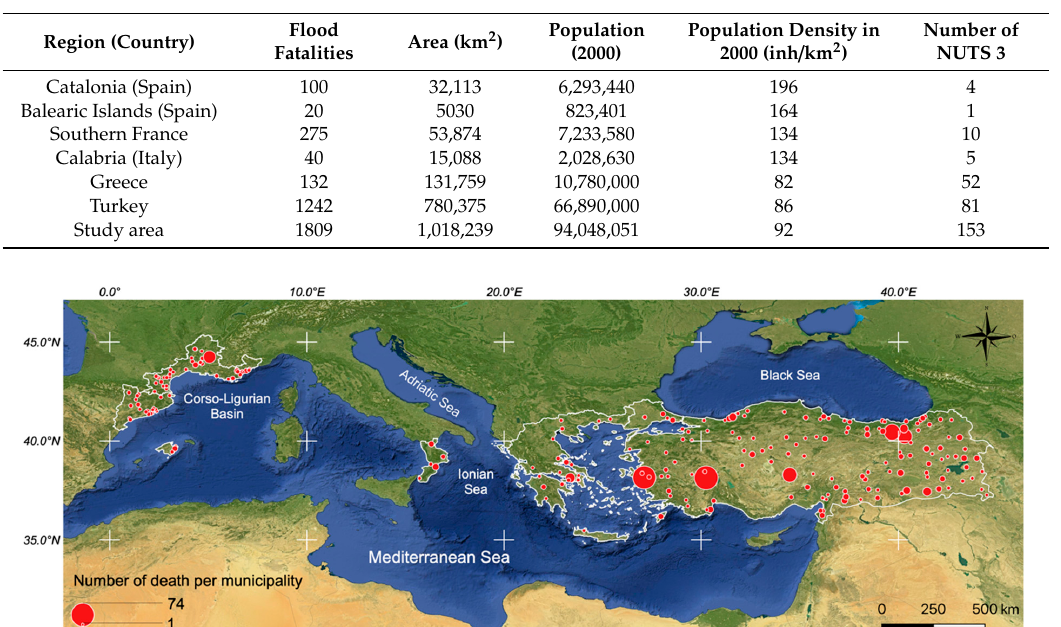
Table 1. General features by country. NUTS3, Nomenclature of Territorial Units for Statistics Level 3.